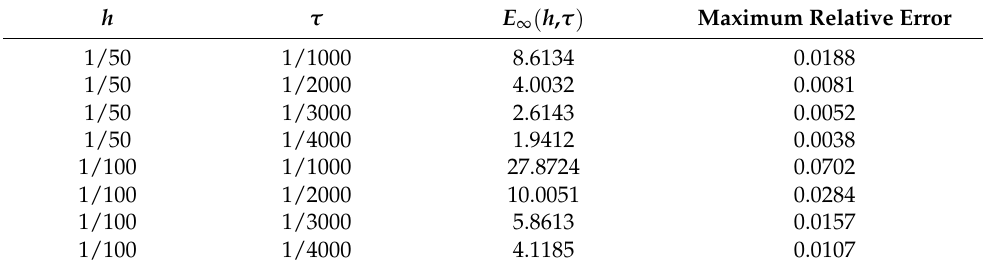
Table 6. The maximum error, E ∞ ( h , τ ) , and the maximum relative error corresponding to the asynchronous step length.